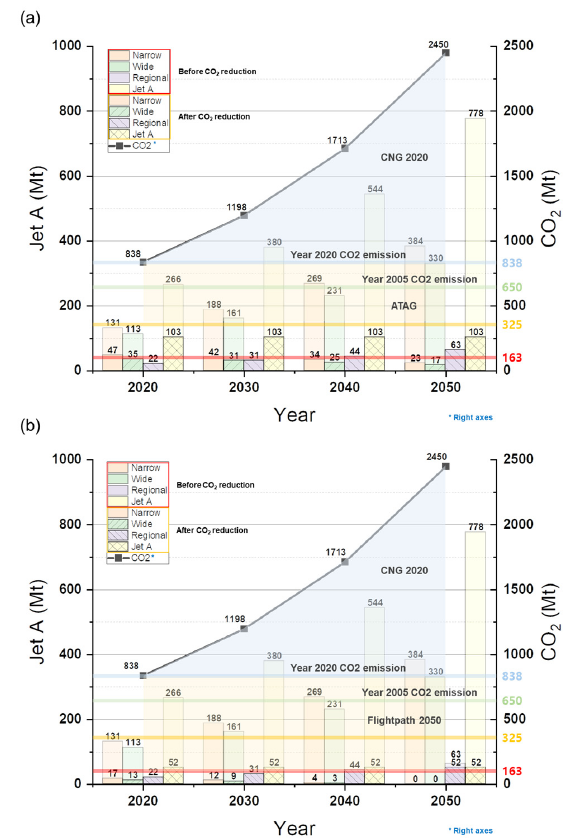
Figure 8. Total Jet A fuel conversion to LH 2 to meet ( a ) ATAG and ( b ) Flightpath 2050.